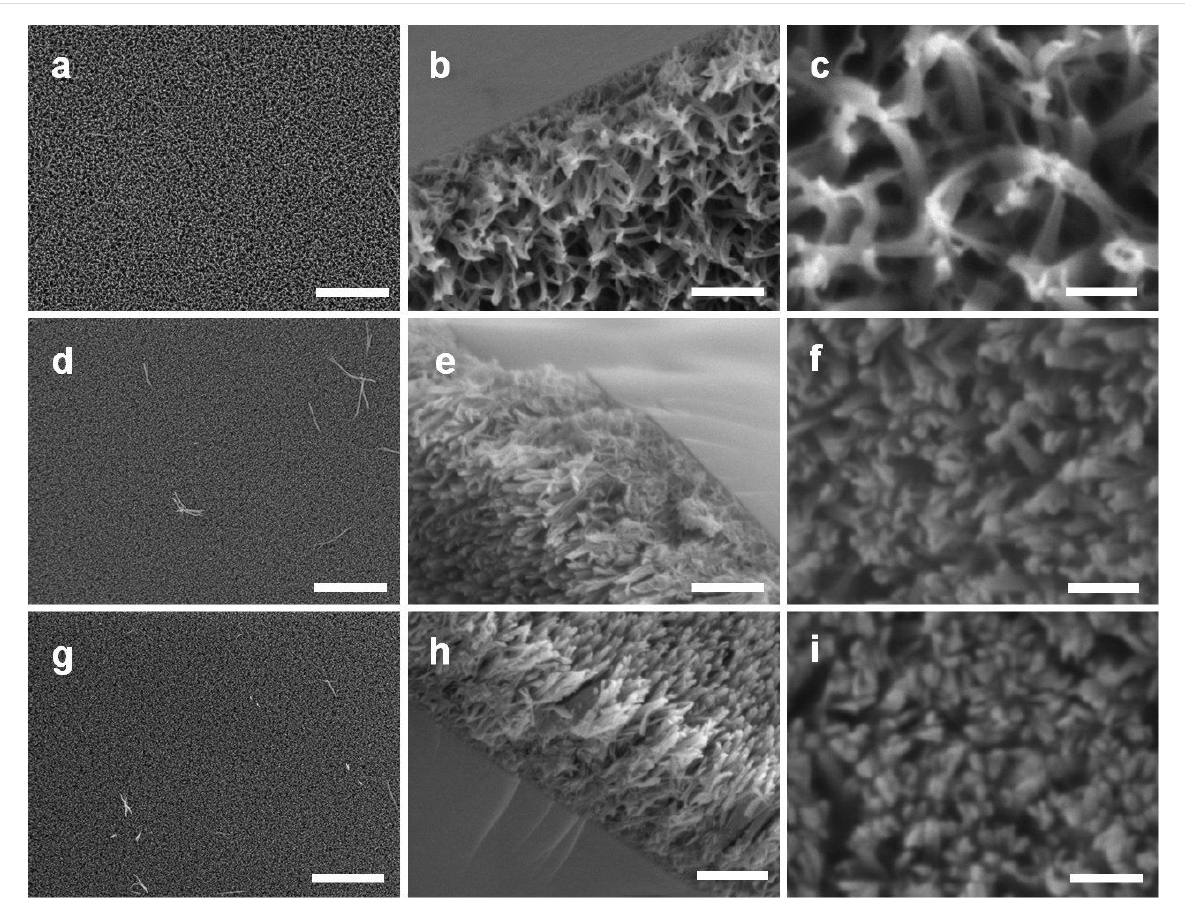
Figure 2: SEM images of LPEI@silica nanograss surface prepared from silica sources corresponding to the mixtures of 15 mL IPA, 15 mL water and 0.5 mL MS51 (a, b and c); 30 mL water and 0.5 mL MS51 (d, e and f); and 30 mL water and 0.5 mL TMOS (g, h and i). The LPEI matrix was formed from 5.0 wt % LPEI in water, and the silica deposition was performed for 40 min at room temperature. The scale bars are 10 μ m (a, d and g); 1 μ m (b, e and h); and 400 nm (c, f and i).